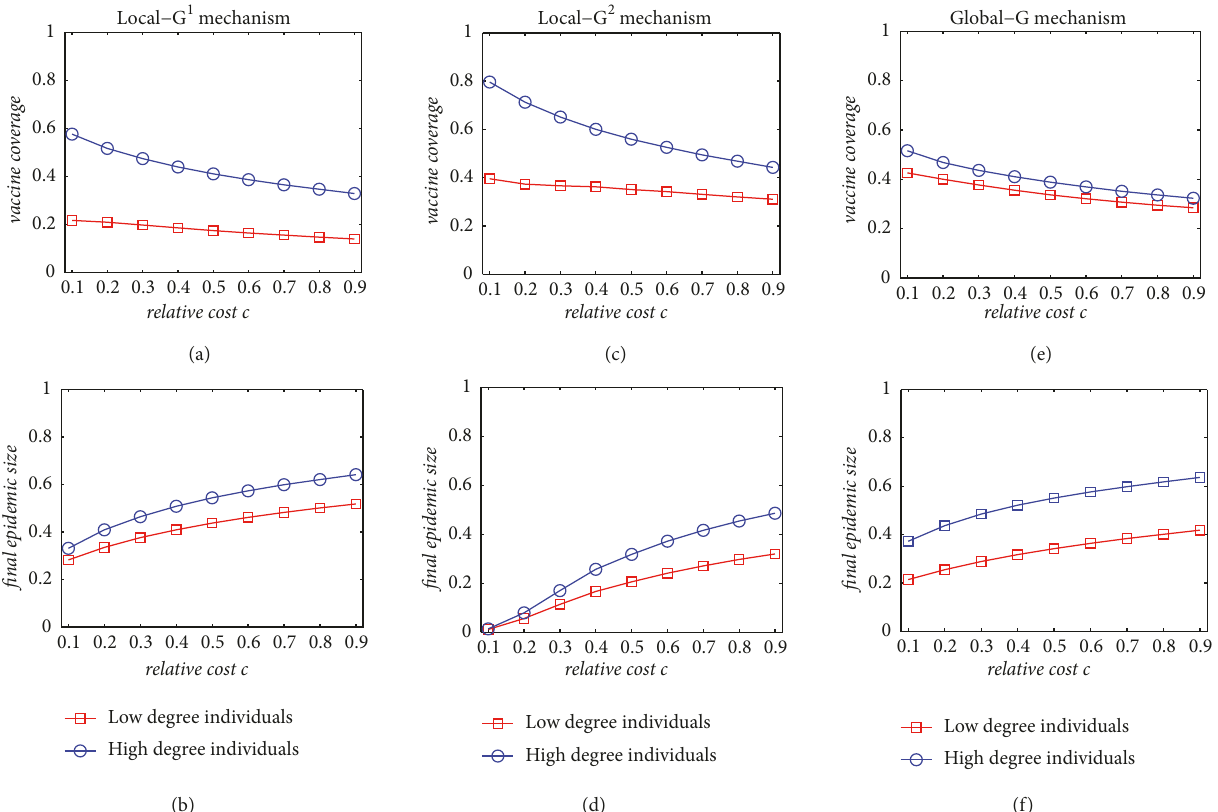
Figure 2: The final vaccine coverage and epidemic size in both high-degree and low-degree groups under different decision-making mechanisms. Simulations are carried out in scale-free networks with network size 𝑁 = 10,000 and average degree ⟨𝑘⟩ = 4 . The results are averaged over the last 500 epidemic